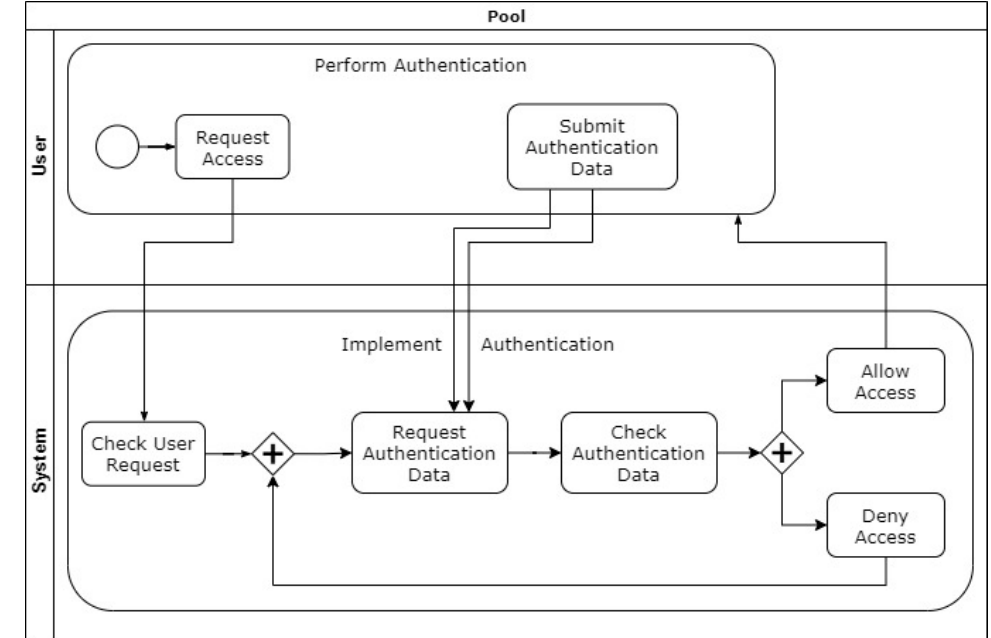
Figure 14. Conceptual overview of Authentication Process pattern [49].